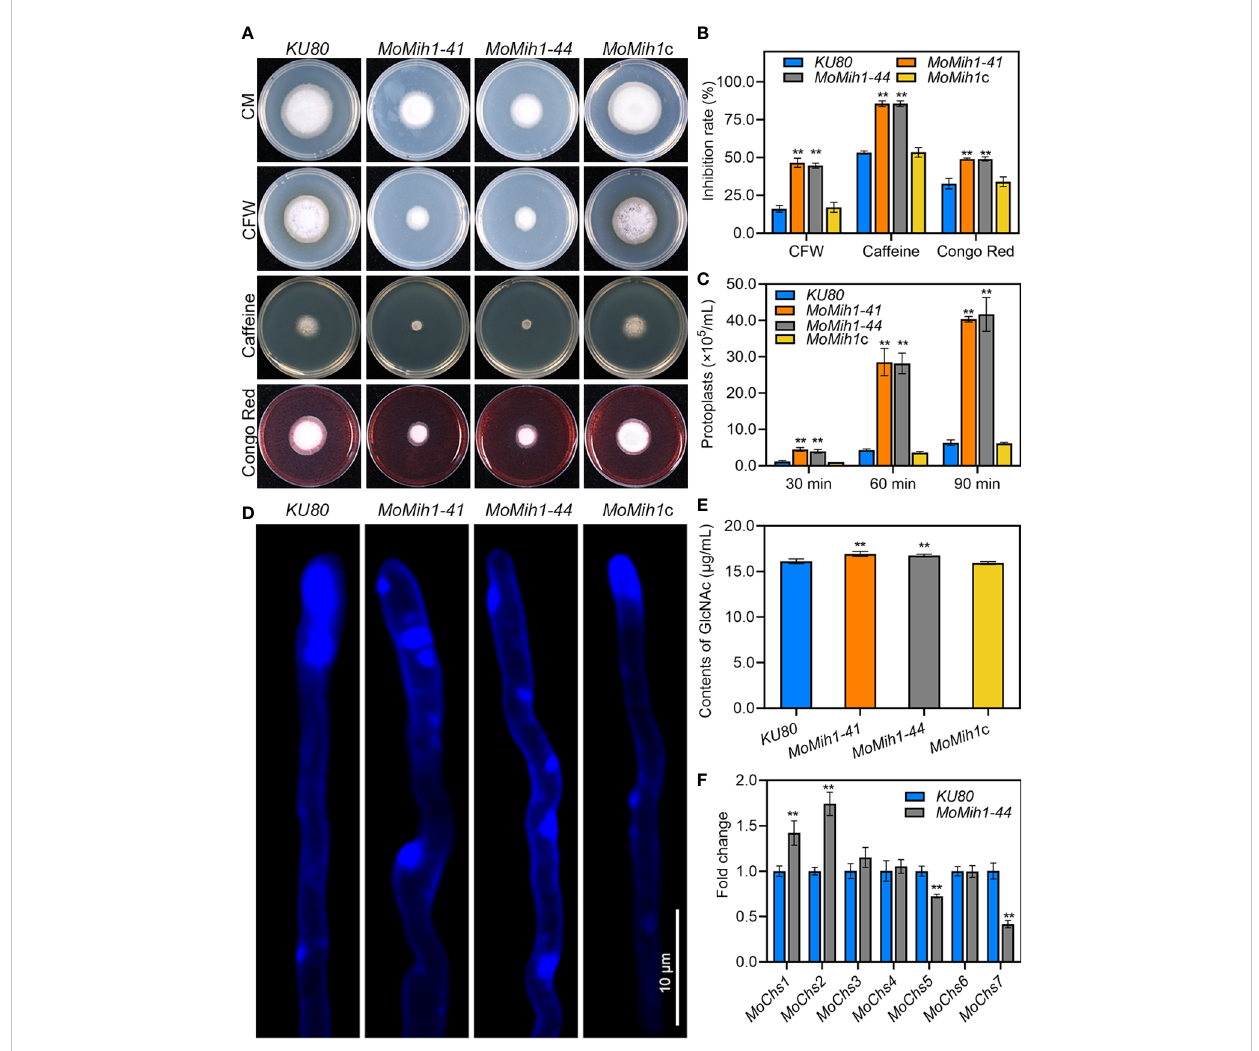
FIGURE 6 MoMih1 is required for cell wall integrity in M. oryzae (A) Mycelial growth under cell wall stressors. The KU80 , MoMih1 mutants and MoMih1 c were inoculated on CM with CFW, caffeine, or Congo red, cultured at 28°C for 5 days, and then photographed. (B) Statistical analysis of the inhibition rate under different cell wall stressors. “ ** ” mean signi fi cant difference between KU80 and MoMih1 mutants ( p < 0.01), and error bars represent SD. (C) Protoplasts released under the treatment of cell wall lysing enzyme. The release of protoplast was quanti fi ed at 30 min intervals. “ ** ” means signi fi cant difference between KU80 and MoMih1 mutants ( p < 0.01), and error bars represent SD. (D) Examination of chitin on the cell wall of MoMih1 mutant. Hypha of KU80 , MoMih1 mutants and MoMih1 c were stained with CFW for 5 min, and then examined under UV fl